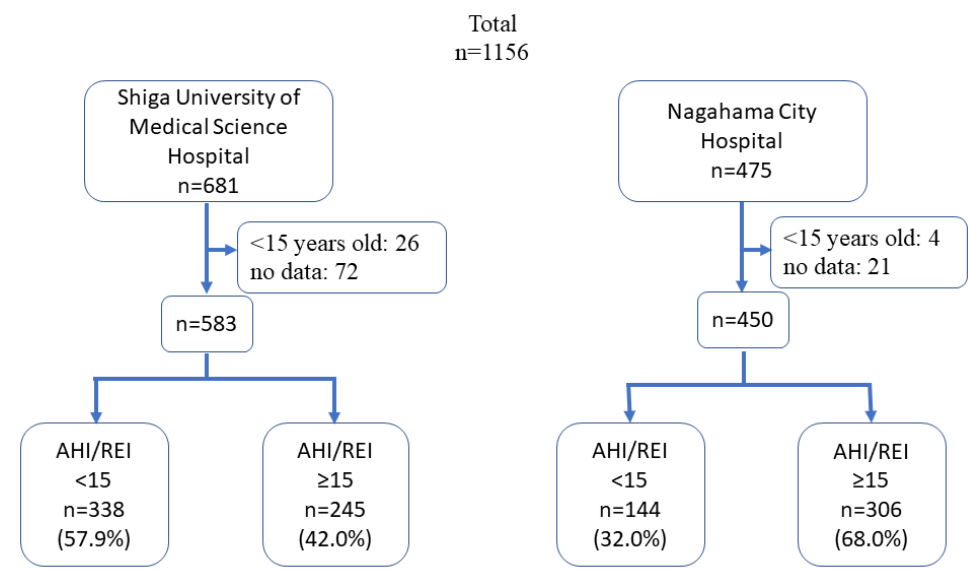
Figure 2. Flowchart of patient inclusion. AHI, apnoea–hypopnea index; REI, respiratory event in- dex.